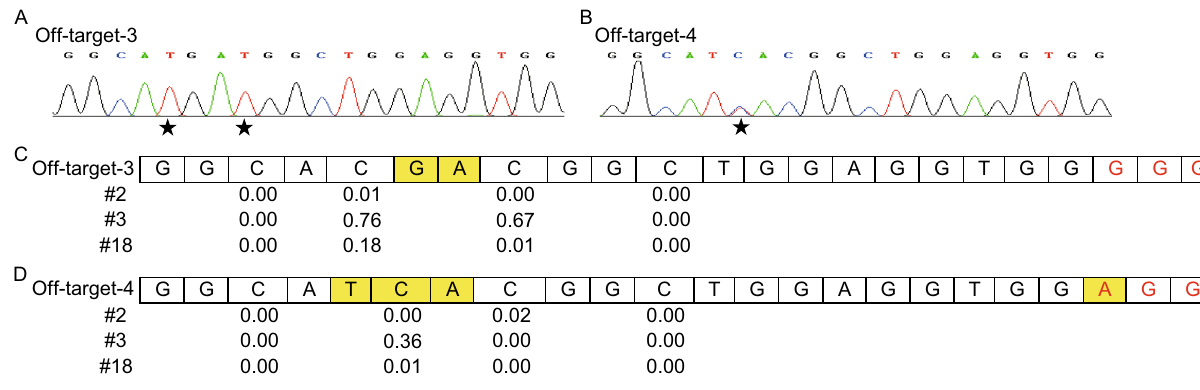
Figure 2. Low off-target mutation detection by BE3 in discarded human tripronuclear embryos . (A) The representative sequence chromatogram of off-target site #3 detected in sample #3. The black stars indicated the conversion of C to T. (B) The representative sequence chromatogram of off-target site #4 detected in sample #3. The black stars indicated the conversion of C to T. (C) Summary of the deep sequencing of the off-target site #3. The editing ef fi ciency of every C within the target site was indicated. The PAM was highlighted in red. The different nucleotides compared with the target site were highlighted in yellow. The PAM was highlighted in red. (D) Summary of the deep sequencing of the off-target site #4. The editing ef fi ciency of every C within the target site was indicated. The PAM was highlighted in red. The different nucleotides compared with the target site were highlighted in yellow. The PAM was highlighted in